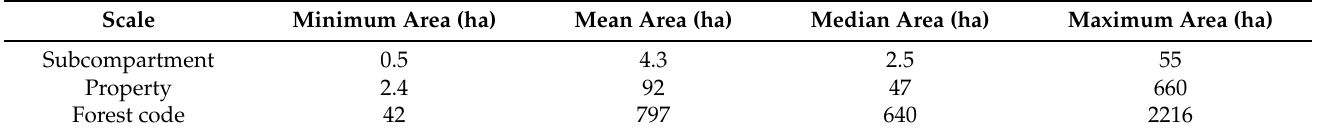
Table 3. Management scale details for the Slieve Blooms.